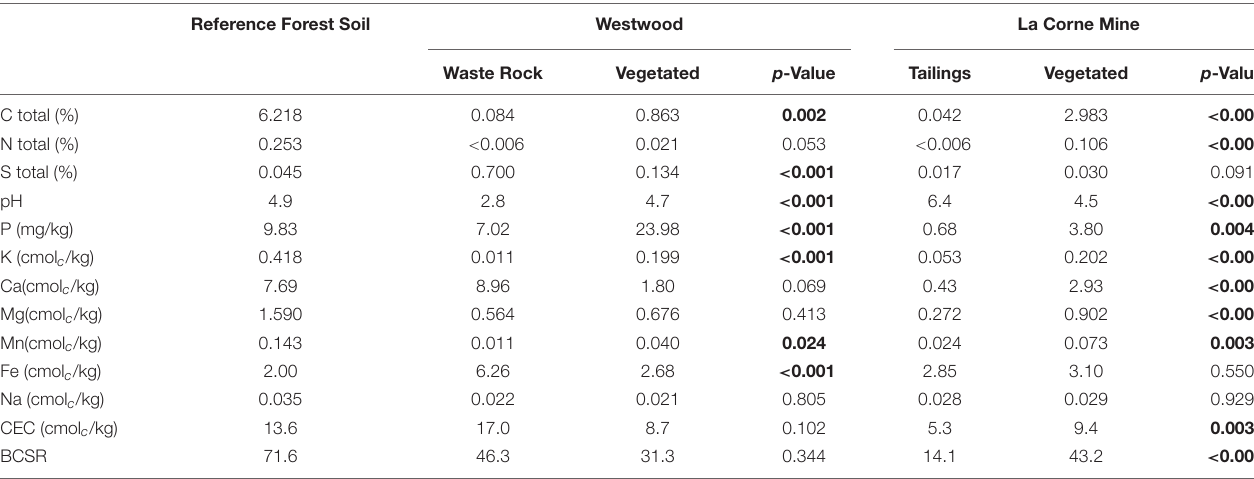
TABLE 1 | Physicochemical properties of substrates from the